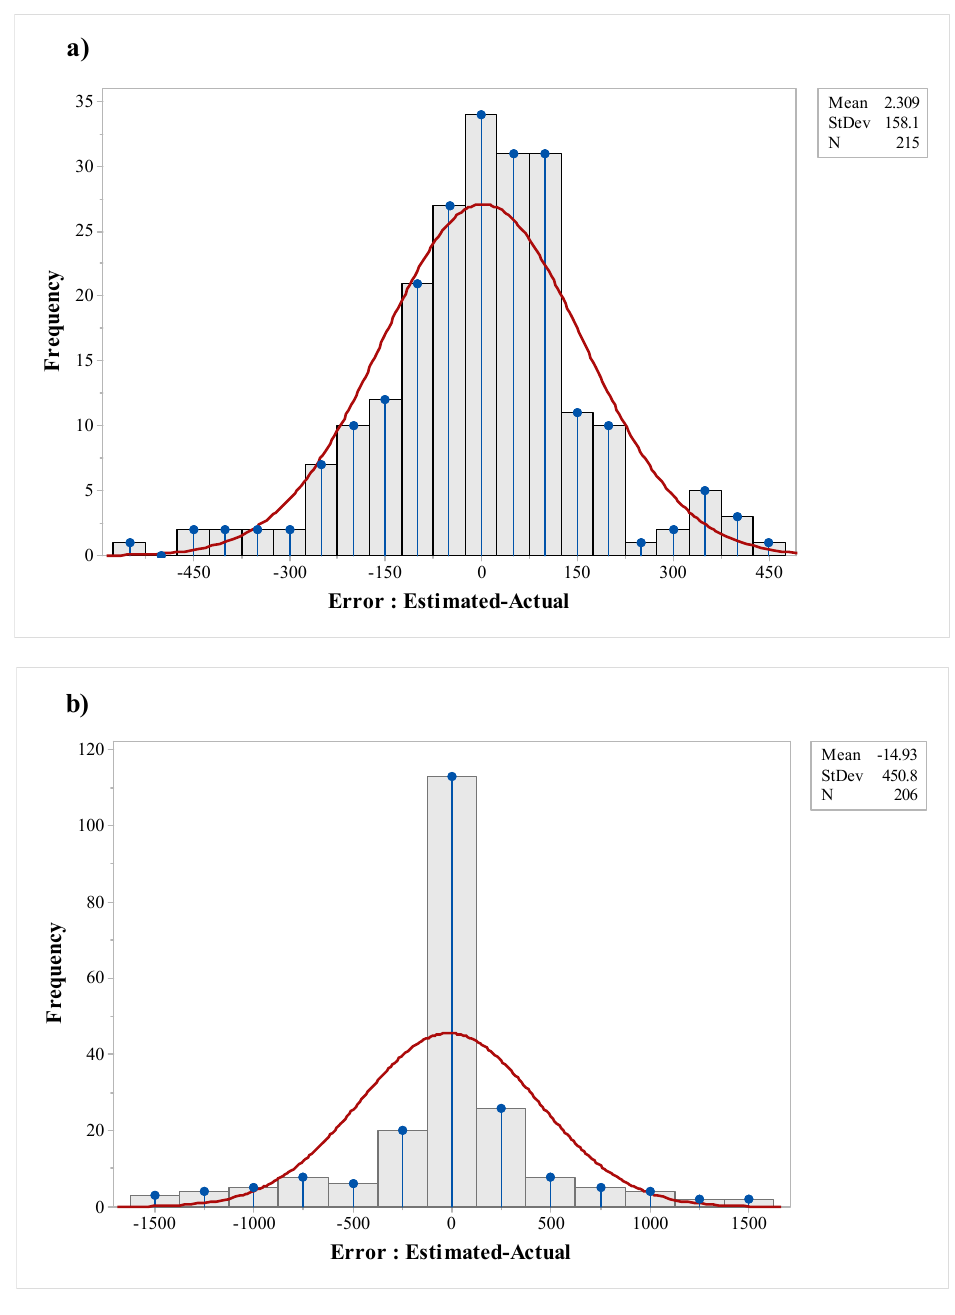
Figure 11. Histogram of the error estimation of Kg ( a ) and Dm ( b ) aquifer.